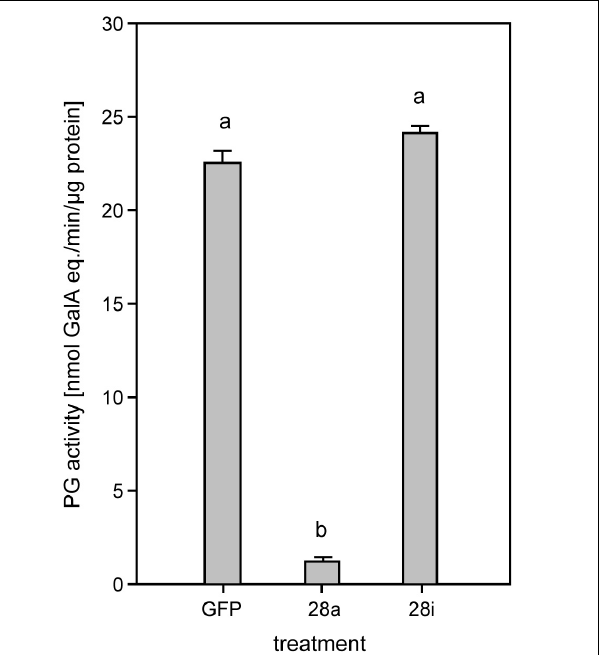
FIGURE 3 | Quantification of PG activity in the P . cochleariae gut content. Hydrolytic activity in the larval guts of the injection control (GFP), active (28a), and inactive (28i) GH28-silenced larvae is shown. Activity is expressed in nmol-reducing uronic acids released per min and µ g of gut content protein.